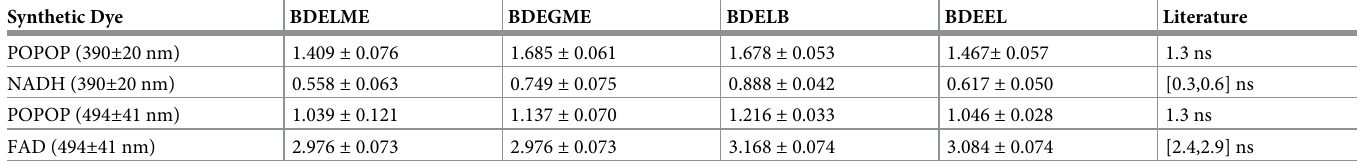
Table 2. Estimated average lifetimes (ns) for synthetic